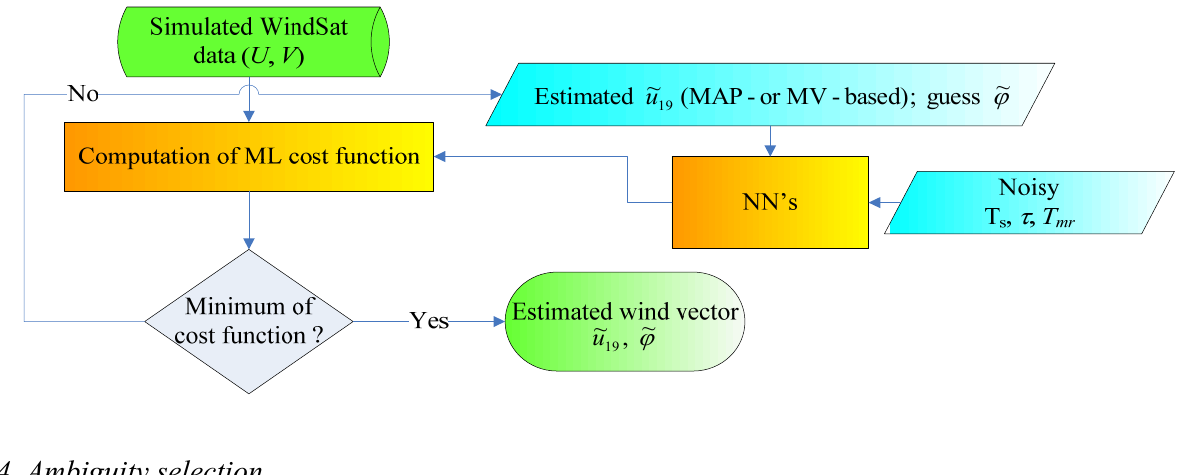
Figure 4 . Block diagram of the ML wind direction